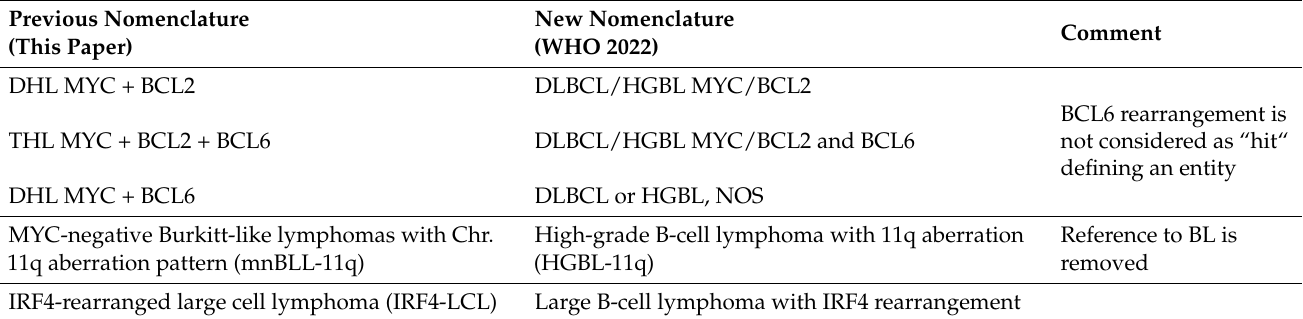
Table 1. New nomenclature for genetic entities considered by WHO 2022